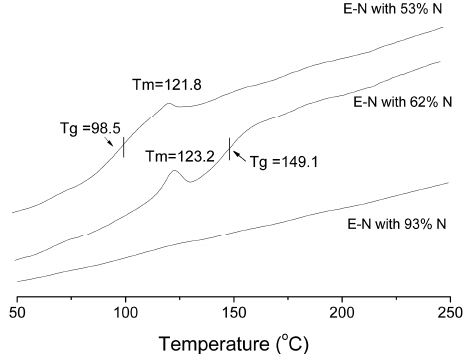
Figure 4. 13 C NMR spectra of E–N copolymers obtained at different ethylene pressures (up: 20 atm (entry 4), down: 0.5 atm (entry 7)). Figure 5. DSC curves of E–N copolymers with different norbornene incorporations.